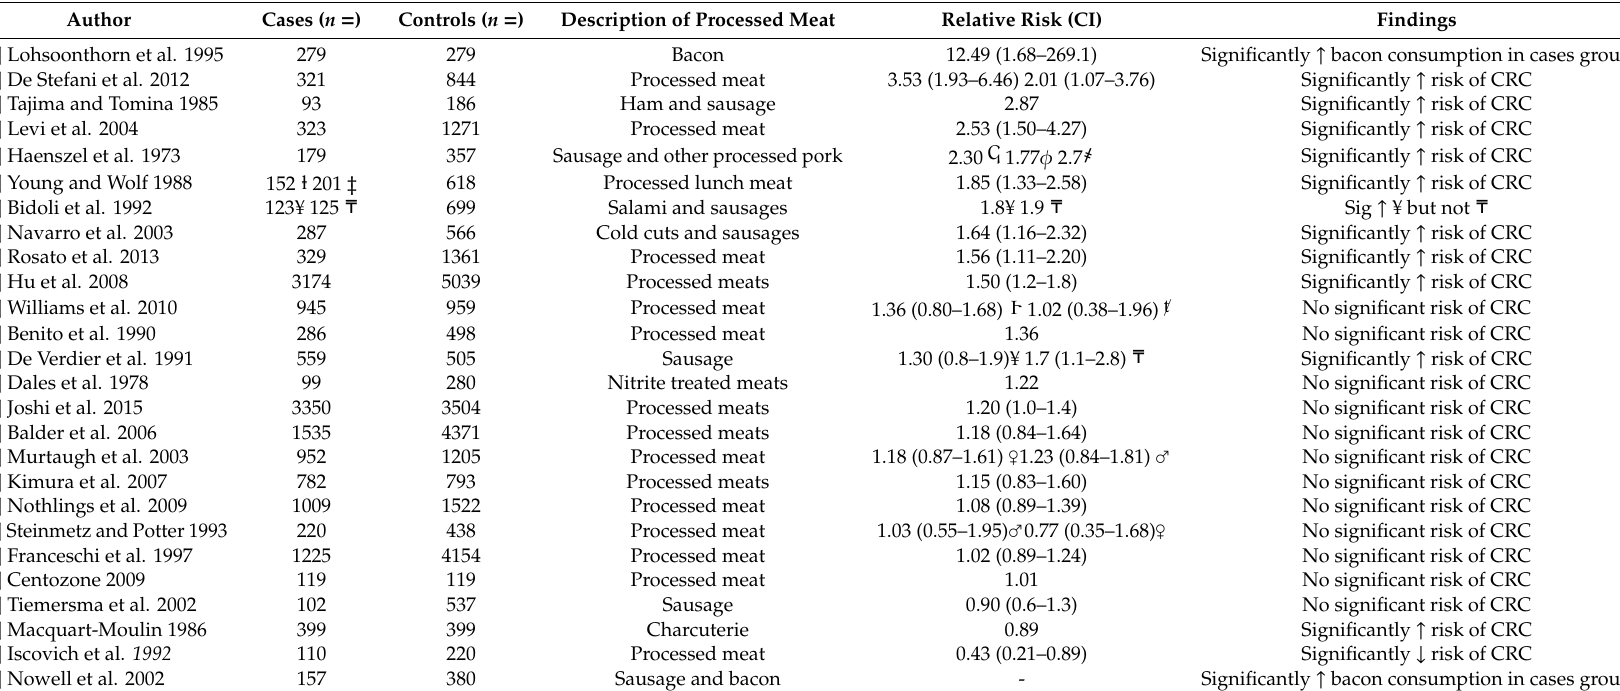
Table 3. Characteristics of case control human studies assessing colorectal cancer and processed meat consumption